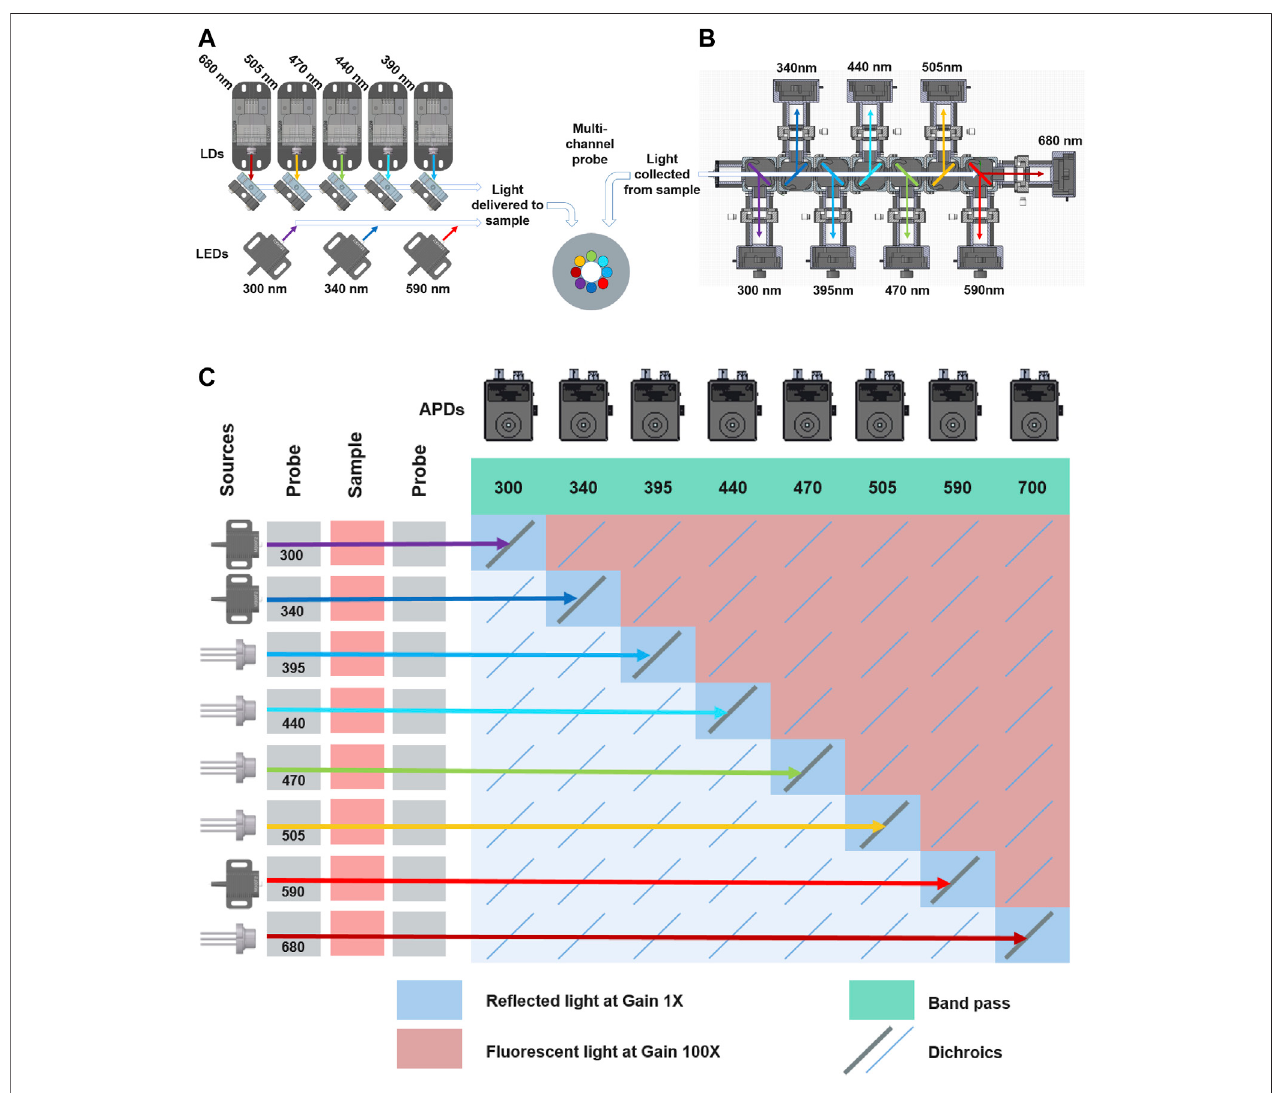
FIGURE 1 | (A) Schematic of illumination sources. The laser diodes were coupled into a single fi bre using the dichroic mirrors, while each LED was coupled to an individual fi bre.Bothilluminationandcollection fi brecomprisedthe fi bre-opticprobe (B) Separationofcollectedlightintodistinctwavelengthsbands. (C) Therelationship between source and detector channels indication type of signal collected, ampli fi er gain as well as corresponding channel.